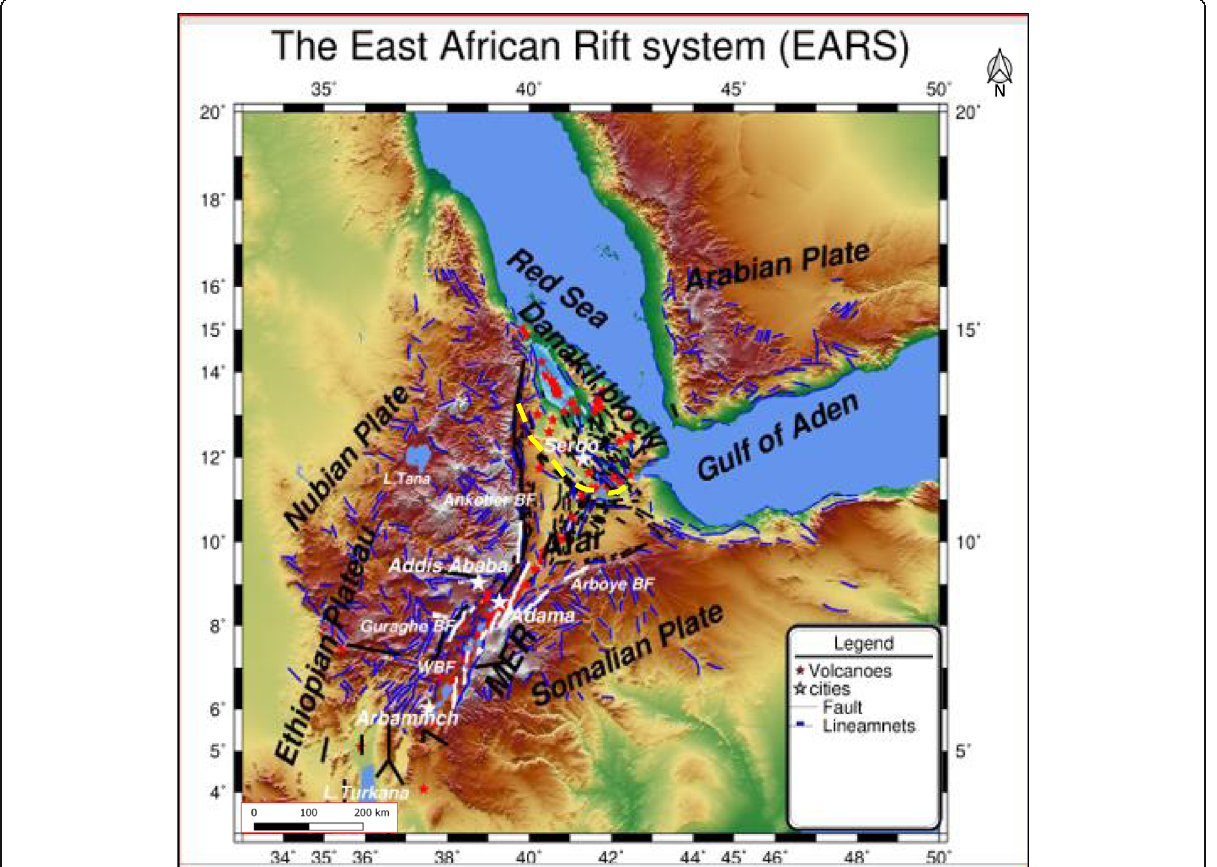
Fig. 1 Tectonic setting of the study region; Colored and shaded relief map of some parts of East African Rift system. Red triangles show volcanoes from the Global Volcanism Program (2013). The East African Rift system separates the Nubian and Somalian plates to the west and east of the rift, respectively. The Arabian plate is separating from Nubia and Somalia with the triple junction at Afar region. The yellow doted curved line indicates the Tendaho-Goba ’ ad Discontinuity. The black lines indicate Normal and Boarder faults. WBF-Wonji Fault Belt, BF- Boarder